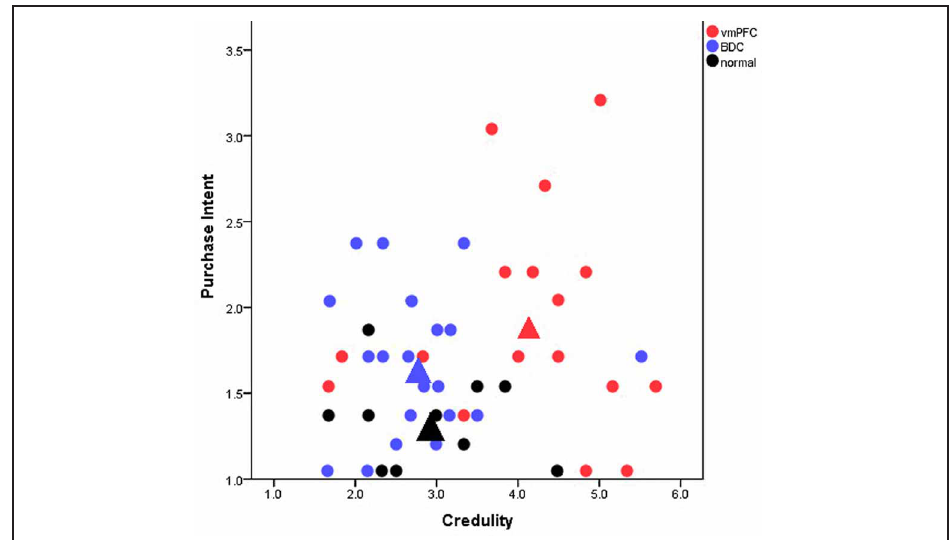
FIGURE 1 | Scatterplot of participants mean credulity and purchase intent toward misleadingly advertised products. Each point represents an individual participant. Red, blue, and black circles represent patients with ventromedial prefrontal cortex (vmPFC) damage, brain-damaged comparison patients (BDC), and healthy comparison participants (normal), respectively. The large triangles represent the overall mean for each group. The y -axis extends from 1 to 5 with higher values corresponding to an increased intent to purchase the products in the ads and lower values to decreased purchase intention. The x -axis extends from 1 to 7 with higher values corresponding to increased belief in the ads (and more credulity) and lower values to increased skepticism. Patients with vmPFC damage where significantly more credulous to the misleading advertisements than comparison participants and displayed the highest intent to purchase the advertised